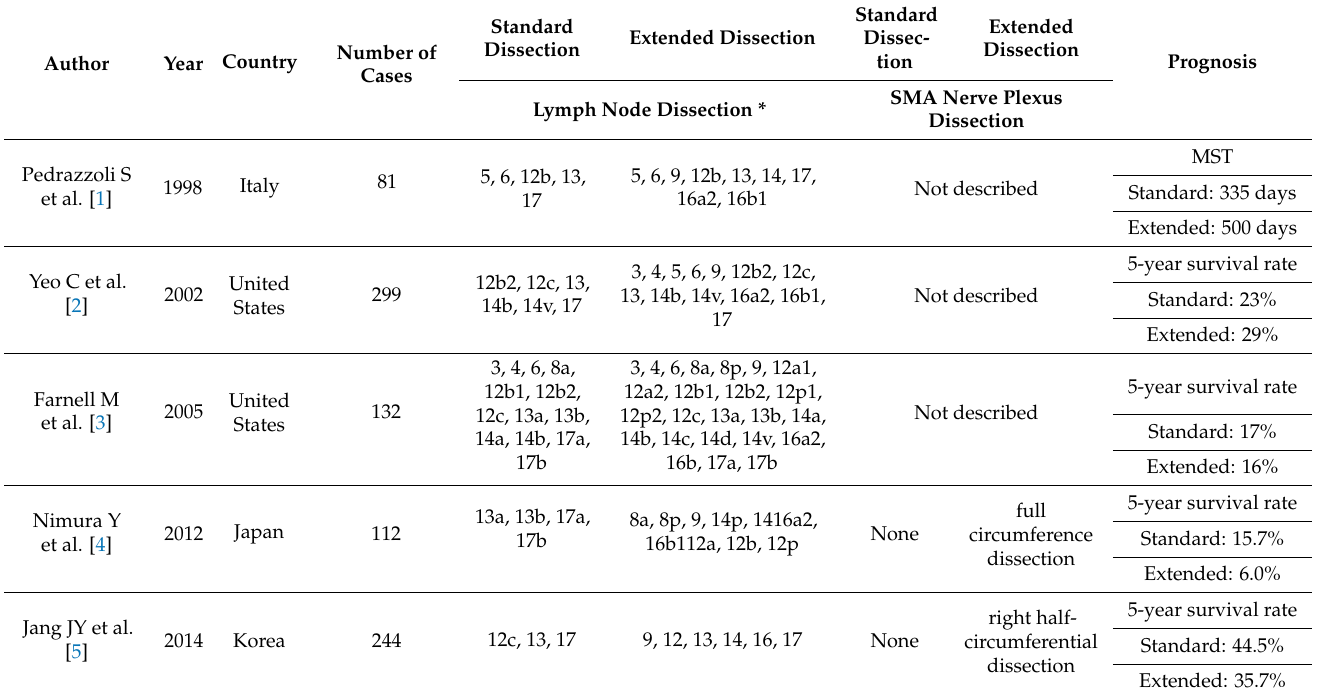
Table 1. Dissection area in randomized controlled trials of extended lymph node dissection and standard dissection for pancreatic head